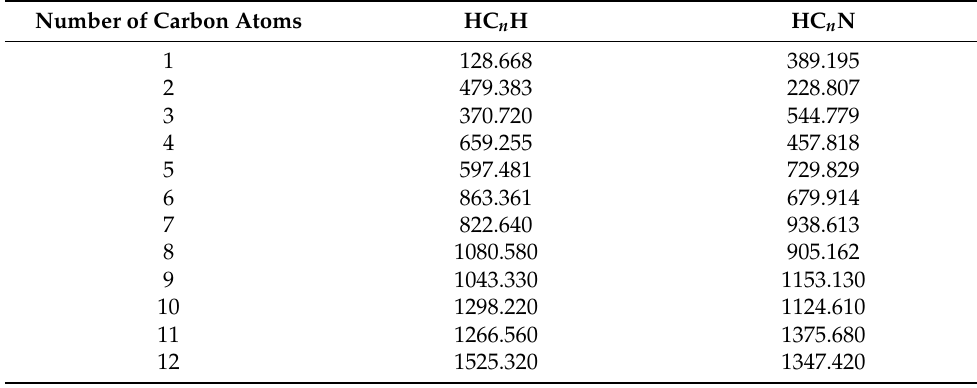
Table 1. Enthalpies of formation of the HC n H and HC n N chain families computed using the G4 composite model. All values are in